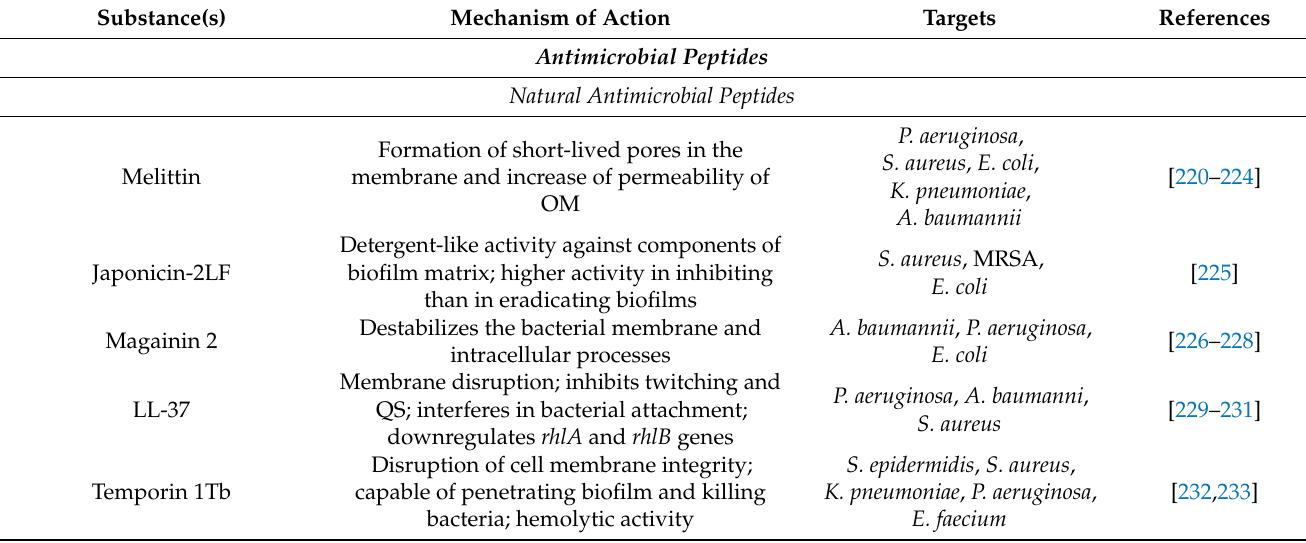
Table 1. Proposed alternatives to antibiotics with antimicrobial or antibiofilm activities. The substance, the mechanism of action (including anti-biofilm activity), and the target bacterial species are indicated for each agent. Substance(s) Mechanism of Action